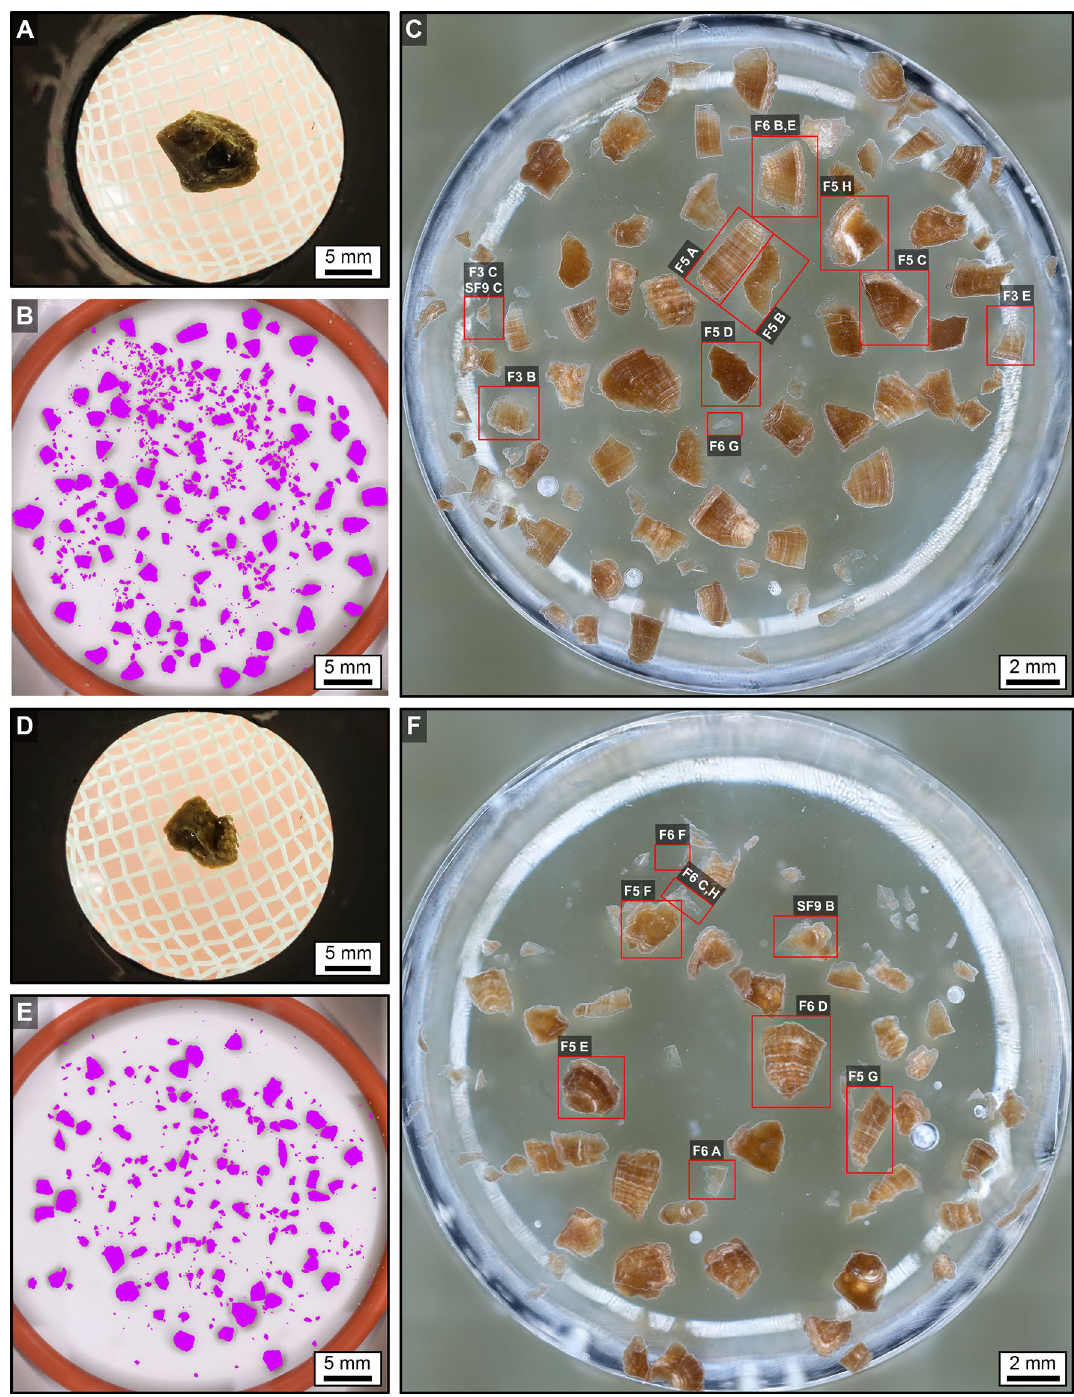
Figure 4. PCNL-derived fragments 106F2 ( A ) and 106F4 ( D ) that underwent SWL to produce particle groups 106F2-S1 ( B , C ) and 106F4-S1 ( E , F ). Particles derived from the first 100 SWL shocks were imaged ( B , E ) and embedded in an epoxy plug ( C , F ). ( A , D ) RL image of PCNL-derived fragment suspended within a 2 mm-mesh net basket prior to SWL treatment. Corresponding figures of 3D external stone morphology, 2D internal crystalline structure, and RL images during experimentation presented in Supplementary Figs. S2 and S4. ( B , E ) RL image of loose SWL-derived particles that were hand-traced and artificially colored pink for precise pixel selection and grain size quantification. ( C , F ) RF image of SWL-derived particles embedded in epoxy and polished prior to thin section preparation (red boxes indicate locations of enlargements shown in Figs. 3, 5, 6, Supplementary Fig.